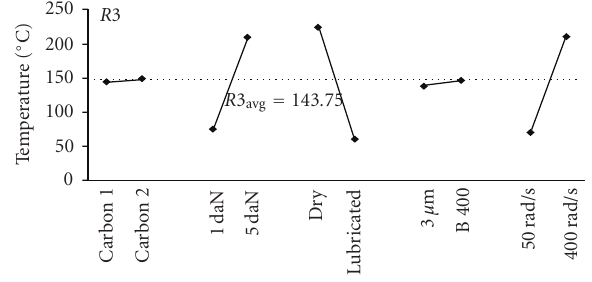
Figure 8: Influence of the studied factors on the temperature maximal measured during the friction test, five millimeters under the friction surface of the primary ring ( R